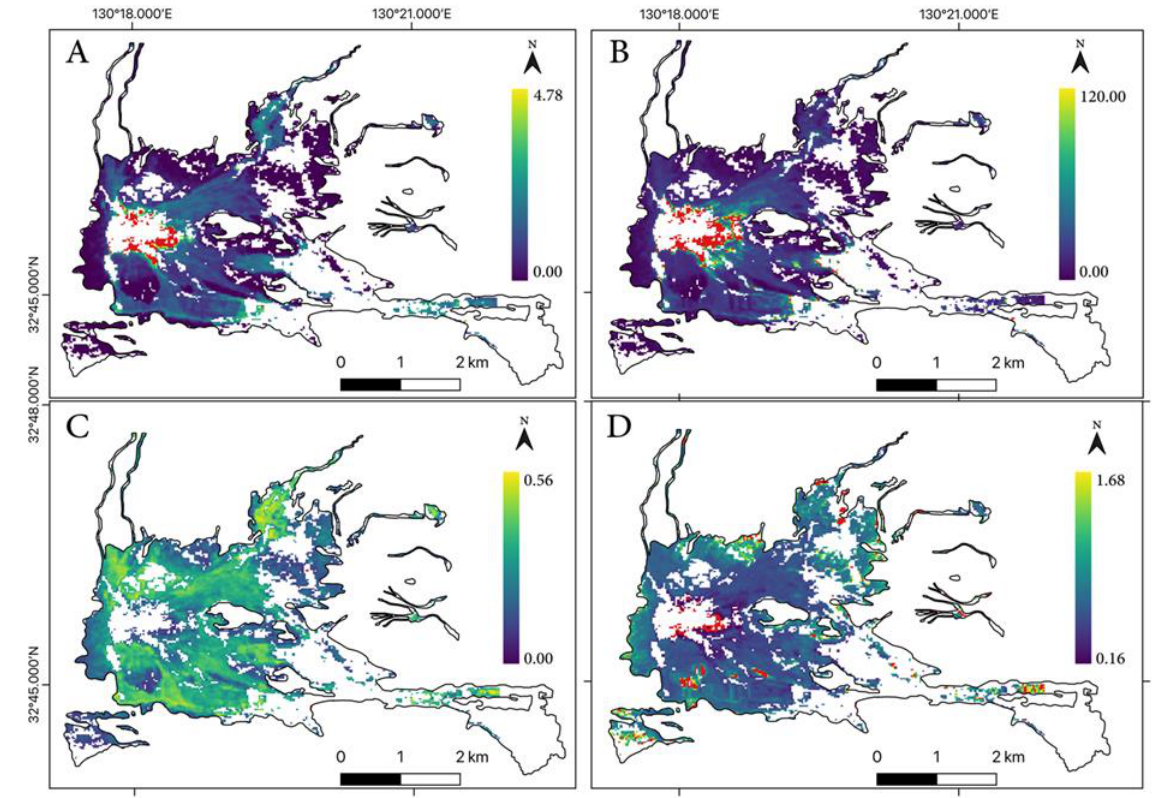
Figure 7. Spatial distribution of response variables. ( A ): Number of years to 20% pre-eruption NBR ( YEAR20 ); ( B ): Number of years to 80% pre-eruption NBR ( YEAR80 ); ( C ): Slope ( β ) of the linear-log model; and ( D ): Recovery Indicator ( RI ). Red pixels represent outliers for each response variable. A thin, black border represents the disturbance zone boundary. Transparent pixels within the disturbance zone indicate pixels derived from poor-fitting regression curves and are not included.